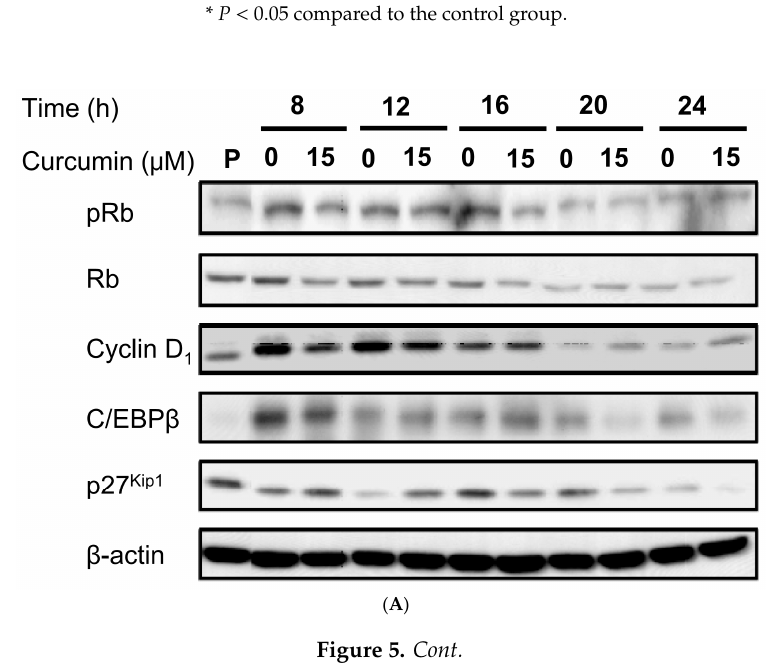
Figure 4. Low dose curcumin inhibits mitotic clonal expansion (MCE) during the early stage of adipocyte differentiation. 3T3-L1 preadipocytes were left untreated (  ) or were pretreated with 15 μ M curcumin (  ) for 1 h, then adipocyte differentiation was induced in the continued presence or absence of curcumin for 0–5 days, when MCE was measured by cell counting ( A ) or the MTT assay ( B ). The results are the mean ± SD for four independent experiments. * P < 0.05 compared to the vehicle control.